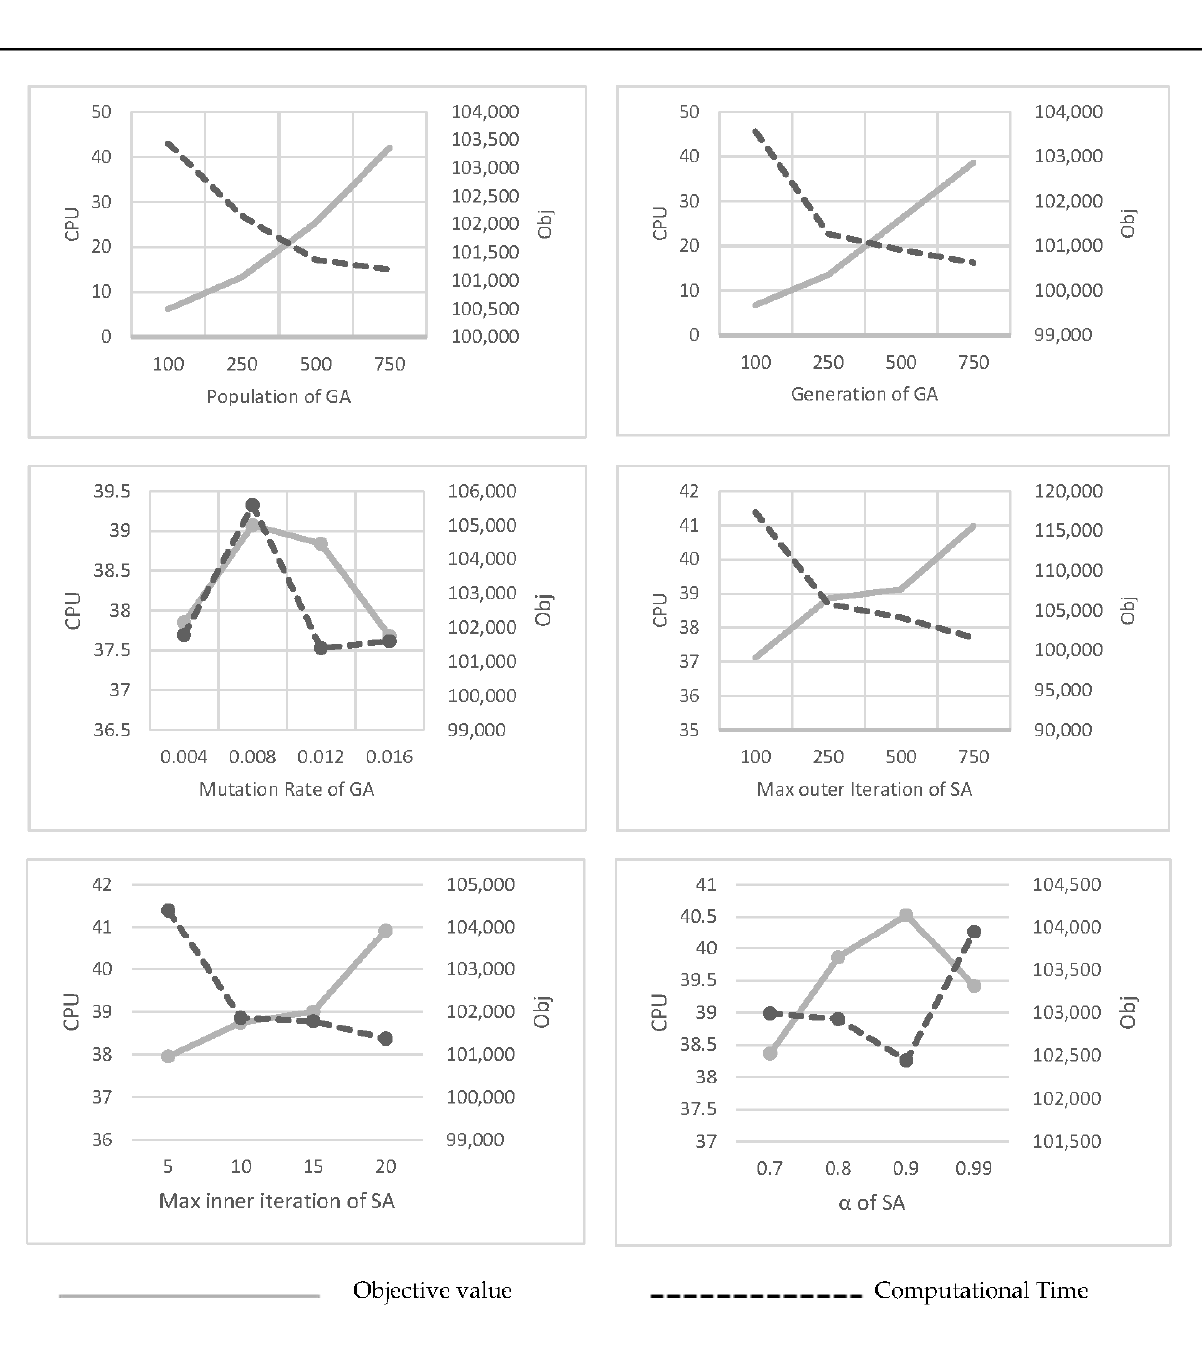
Figure 5. Effect of GA and SA parameters on computational time and objective value.